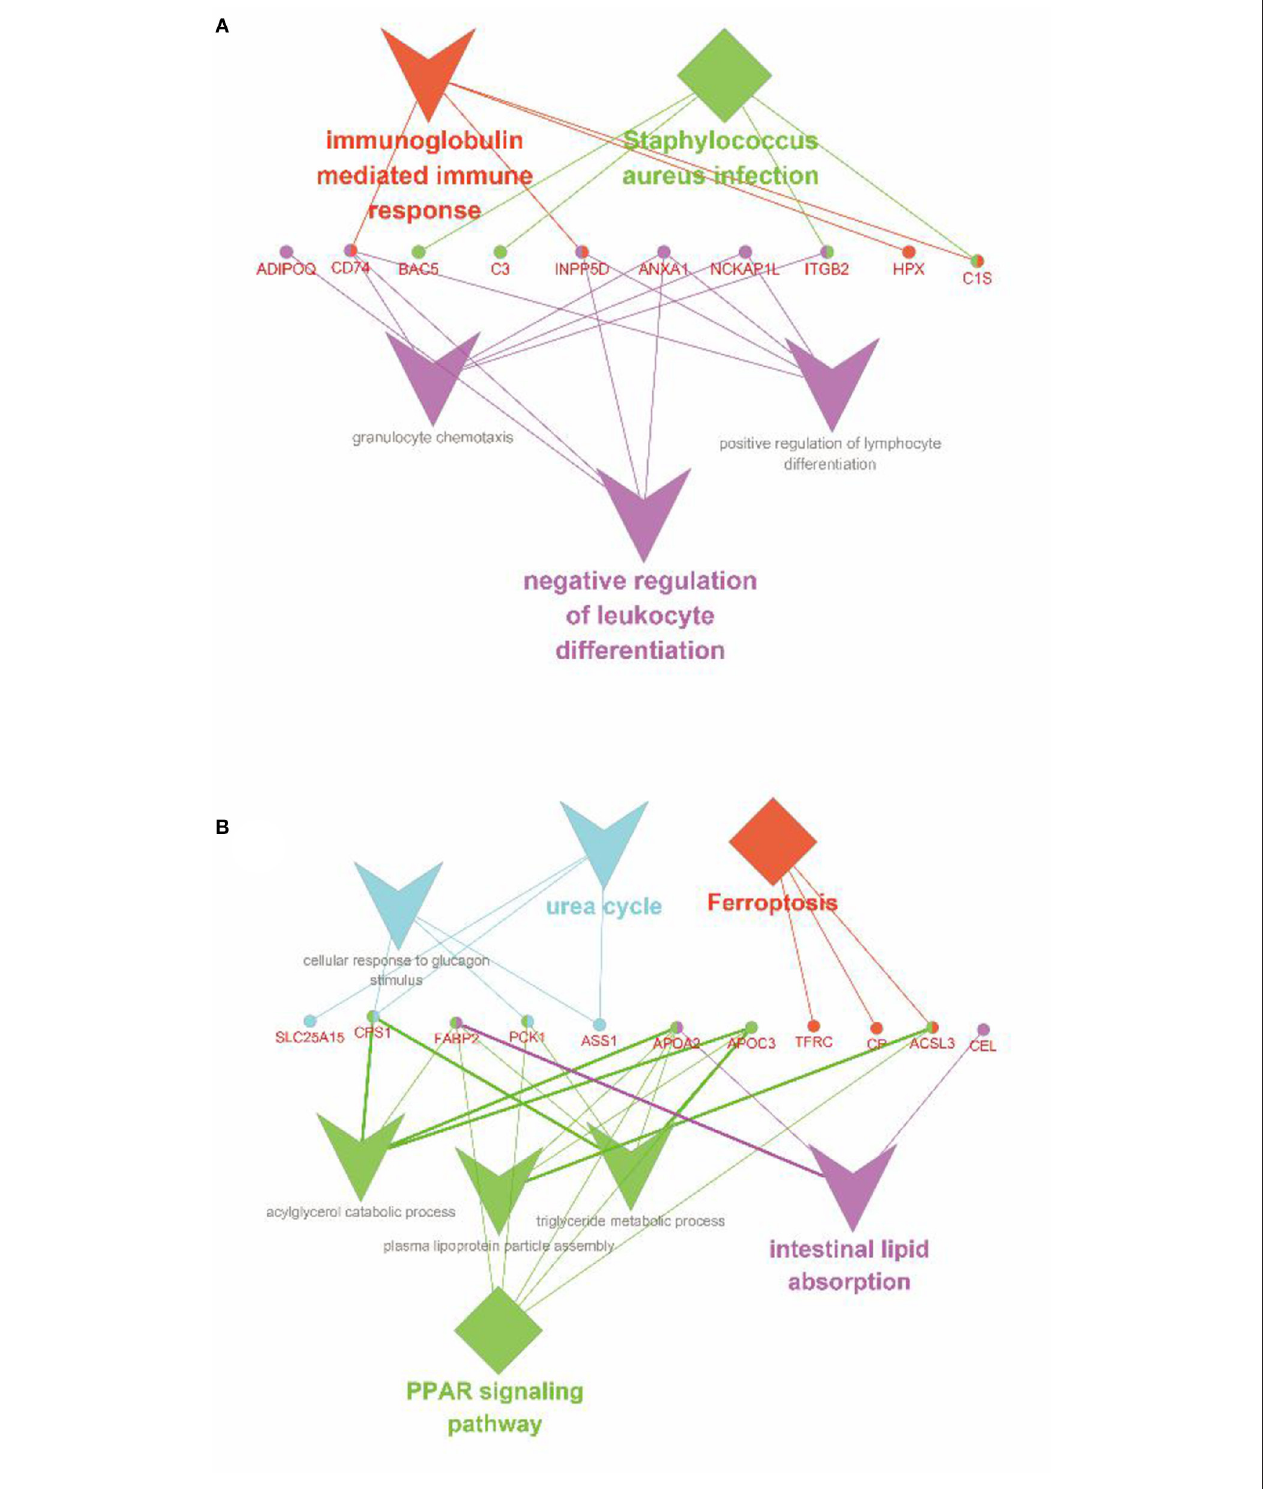
FIGURE 7 | Enrichment analysis of the co-expressed DEGs between transcriptome and proteome. (A) Enrichment analysis of the genes, which were upregulated in transcriptome but downregulated in proteome. (B) Enrichment analysis of the genes, which were downregulated in transcriptome and proteome. The diamond represented the metabolic pathways in the KEGG database; the triangle represented the functions in the GO database; the circle showed the genes; the different colors represented the different functional groups, respectively, based on kappa score.